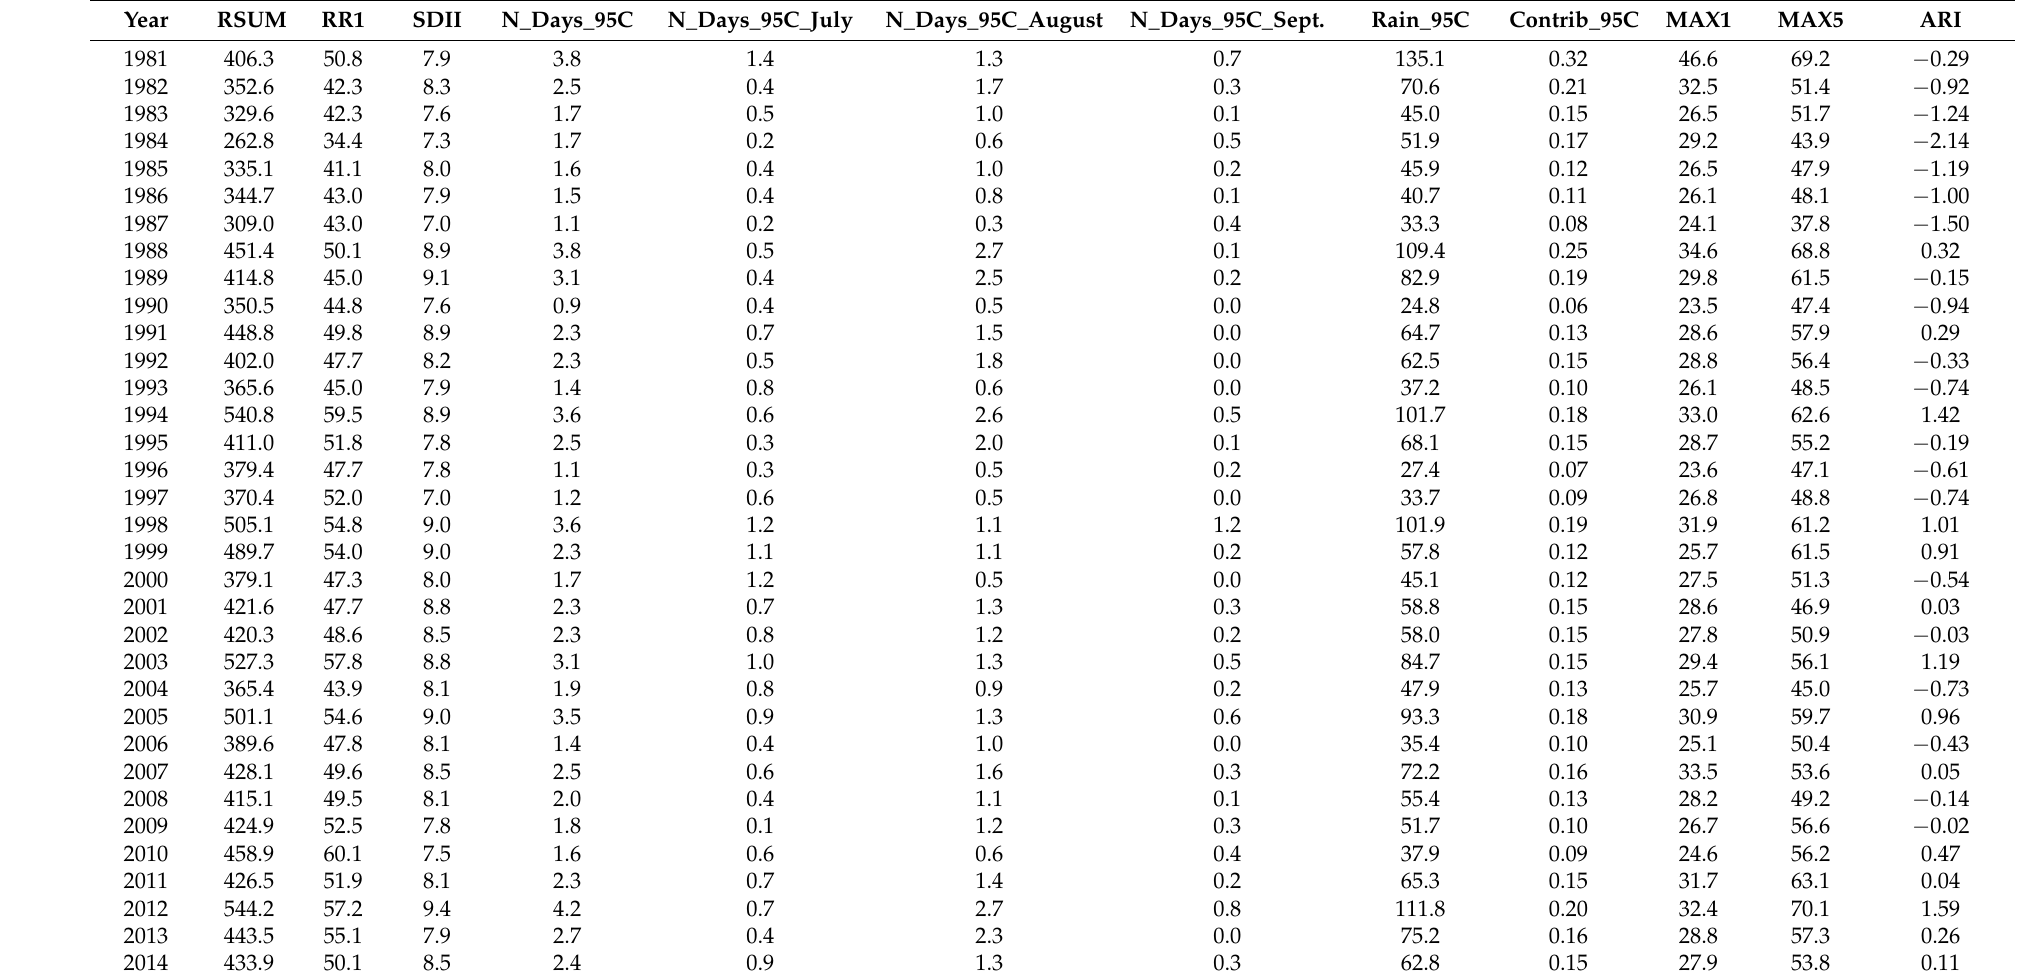
Table A4. Rainfall indexes over the